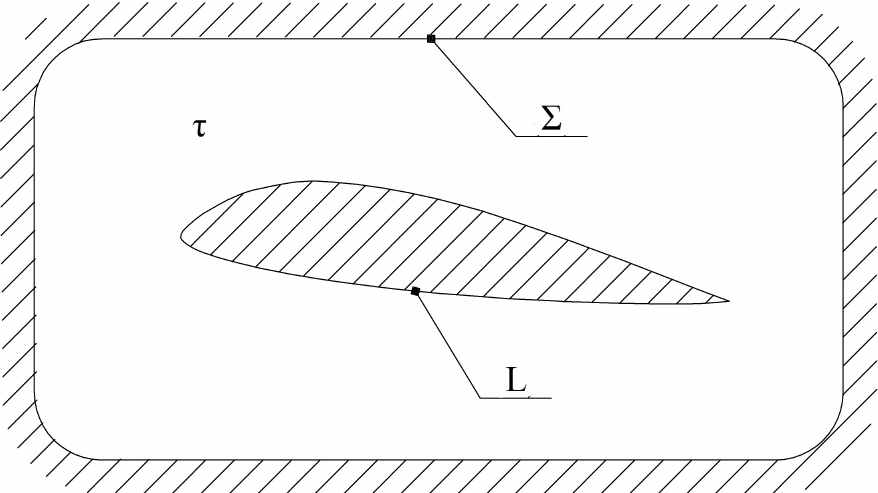
Figure 2. The position of the region τ with the boundaries Σ and